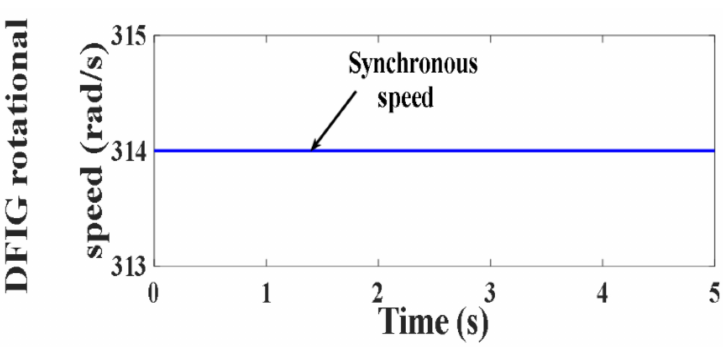
Figure 107. Prime mover operating speeds (rad/s).